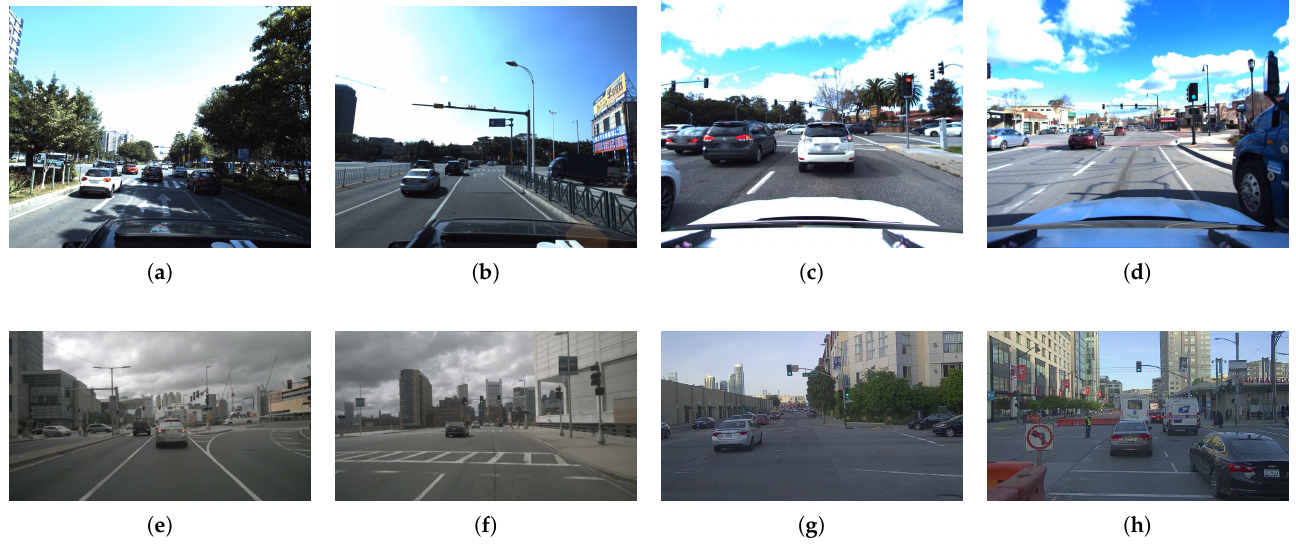
Figure 1. Typical intersections in the well-known ApolloScape ( a , b ), Lyft-5 ( c , d ), NuScenes ( e , f ), and Pandaset ( g , h ) datasets. The intersection geometry configuration on these Manhattan-like environments is simple and repetitive, and the dominant difference consists only on the traffic conditions. Moreover, it is of extreme difficulty to generalize these kinds of settings to mid-sized cities.